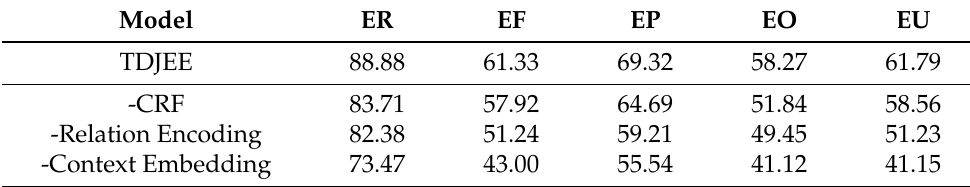
Table 6. Performance (F1 score) of TDJEE and its variants on five types of